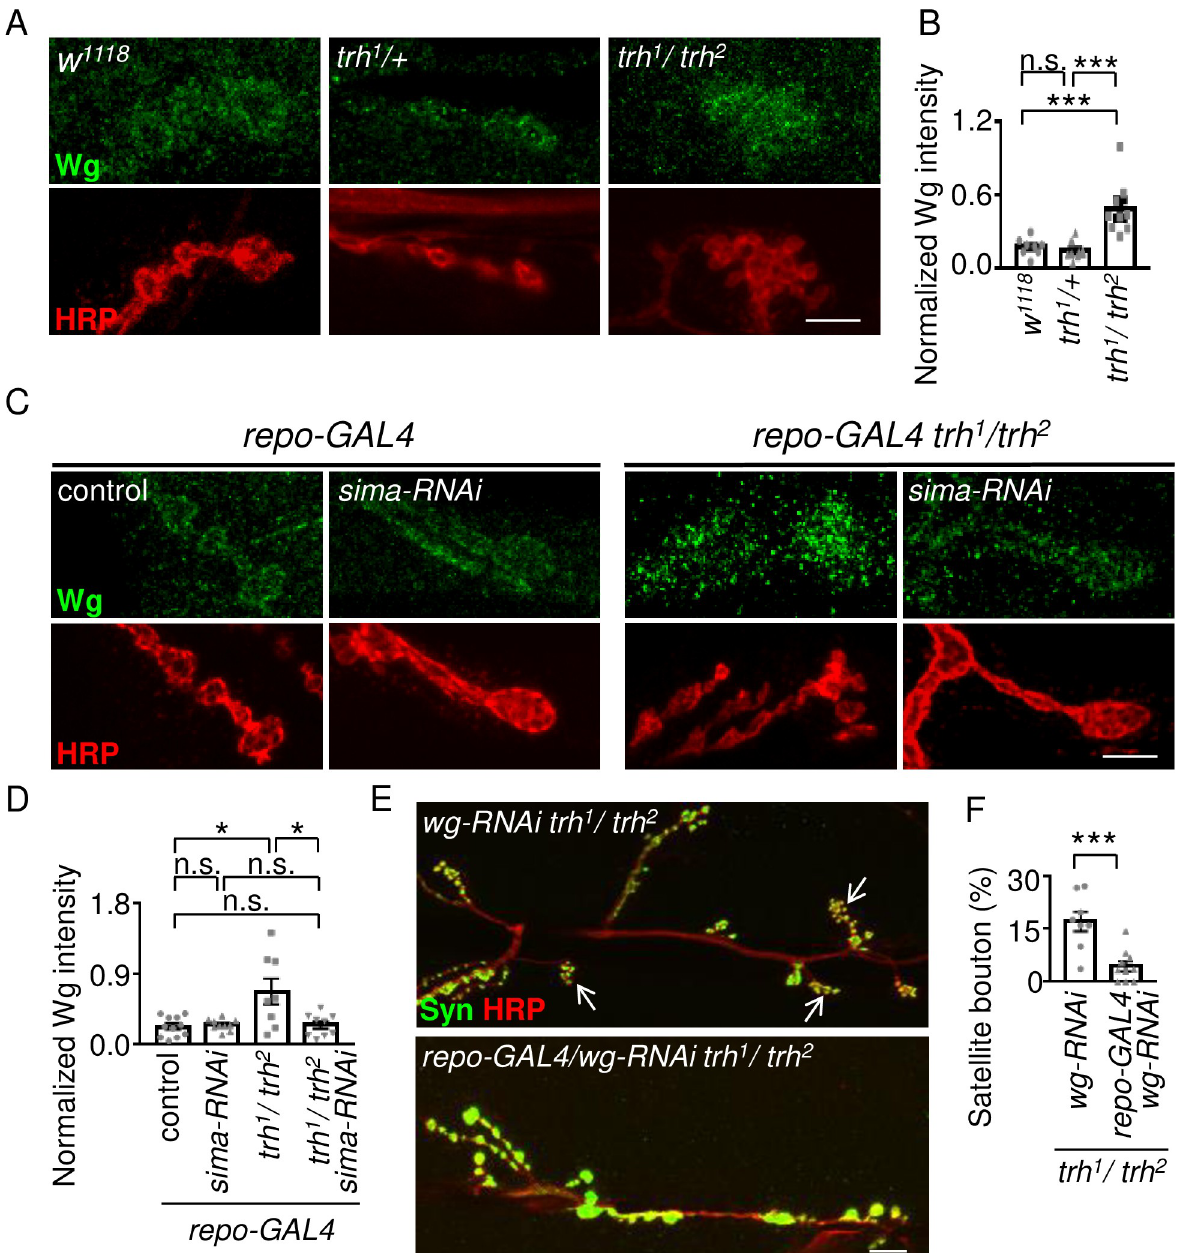
Fig 4. Wg induction from glia modulates synapse formation at trh NMJs. (A, C, E) Images showing NMJs of muscle 6/7 immunostained for Wg (green) and HRP (red) in w 1118 , trh 1 /+ , and trh 1 /trh 2 (A); repo-GAL4 , repo-GAL4 / sima-RNAi , repo-GAL4 trh 1 /trh 2 , and repo-GAL4/sima-RNAi trh 1 / trh 2 (C); and for Syn (green) and HRP (red) in wg-RNAi trh 1 /trh 2 and repo-GAL4/wg-RNAi trh 1 /trh 2 (E). White arrows indicate clusters of satellite boutons. Scale bars represent 5 μ m. (B, D, F) Bar graphs show averages (mean ± SEM) of normalized Wg to HRP intensities (B, D), and percentages (mean ± SEM) of satellite boutons (F). Statistical significance by Mann-Whitney test is shown (n.s., no significance; � , p < 0.05; ��� , p <